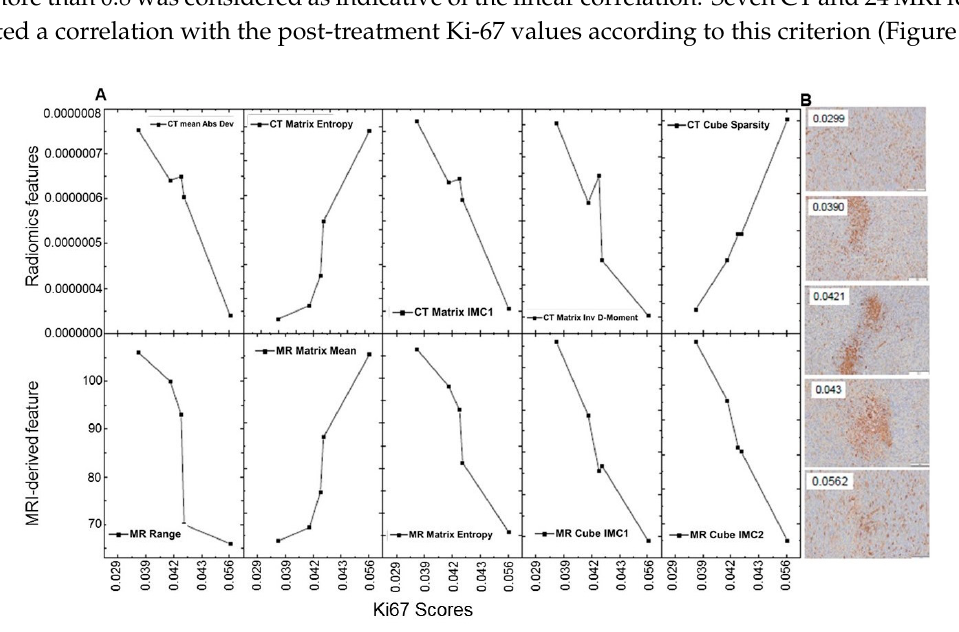
Table 1. Pearson correlation coefficients and significance level for CT-derived imaging features, which exhibit correlation with Ki-67marker.